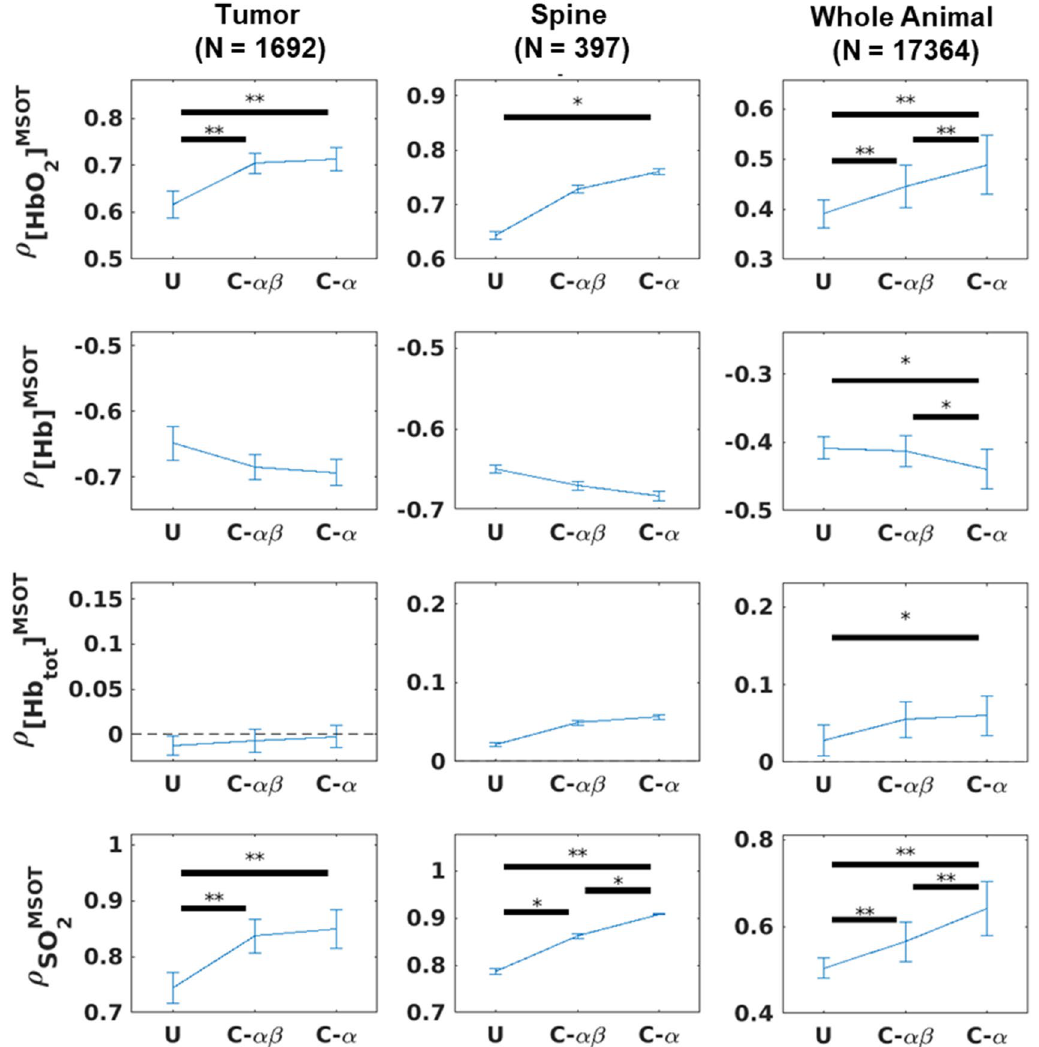
Figure 12. Plots of average correlation for distinct ROIs of Dataset B. A general improvement in correlation is seen using either of the constrained approaches, though the superior noise-rejection properties of the α filter enable it to achieve better overall correlation with the gas challenge pO 2 time course. Figure created using a combination of MATLAB and Microsoft